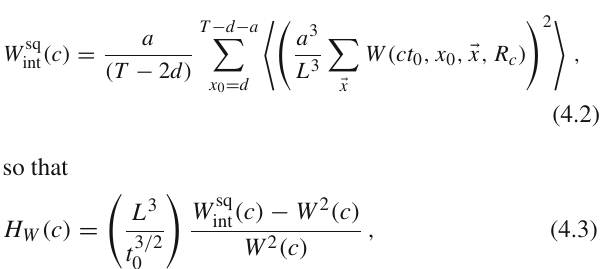
Fig. 2 ¯ λ GF asafunctionof t forseveralvaluesof N and a (seeTable1). In the lower plot, we present a closer look at the small t region